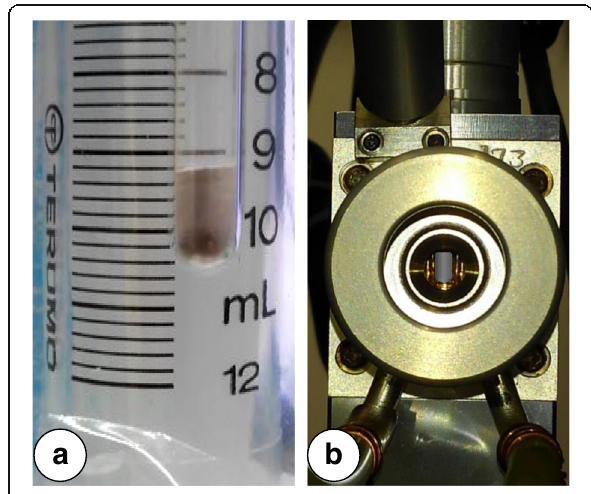
Fig. 1 Photographs of DND powder in a the JEOL EPR tube and b in the centre of X-band microwave cavity. For comparative purposes, the image of the powder in the EPR tube is specially taken against the main part of a plastic syringe with a volume of